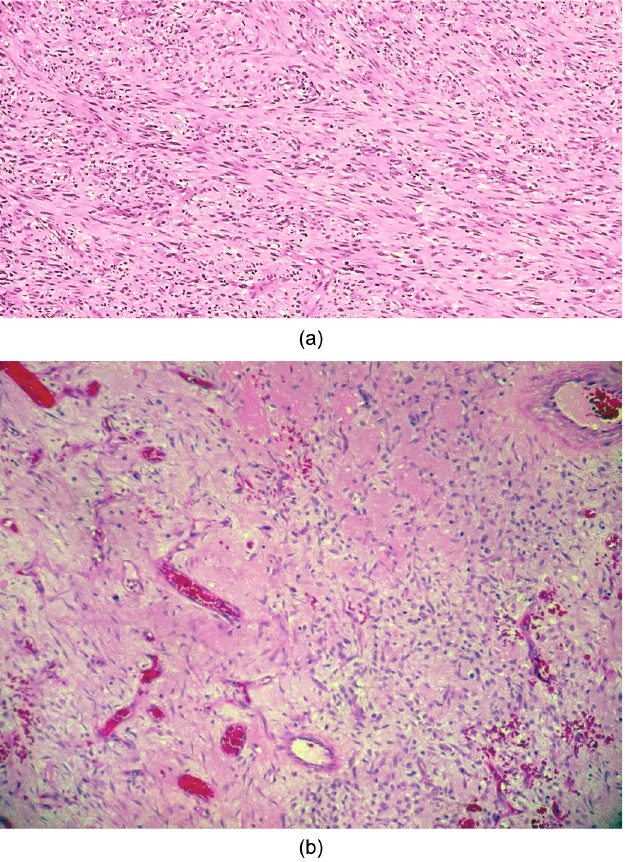
Fig. 3. Case 2. Histopathological examination of the haematoxylin- eosin stained specimen. Proliferation of tapered spindle cells resembling myo fi broblast in long fascicular pattern, alternating with haphazard pattern arrangement (a); Scattered capillaries are also seen (b) (a and b, 100 (cid:1) ).